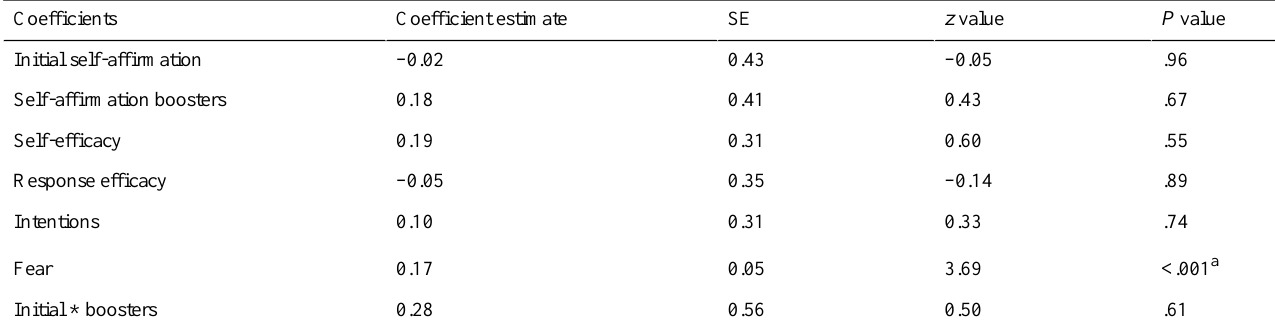
Table 2. Coefficients for the Cox proportional hazards model.